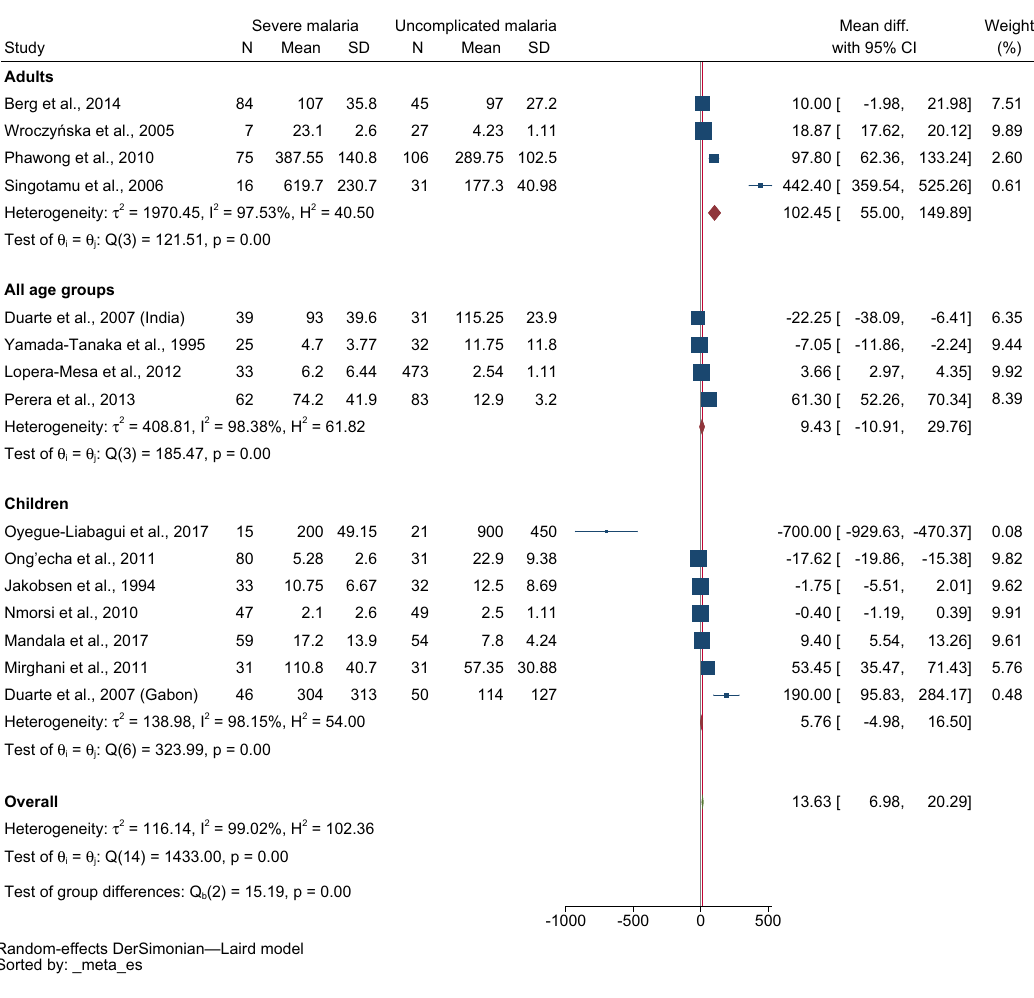
Figure 4. Forest plot demonstrating the pooled MD of INF-γ levels between patients with severe and uncomplicated malaria stratified by age group . CI confidence interval, SD standard